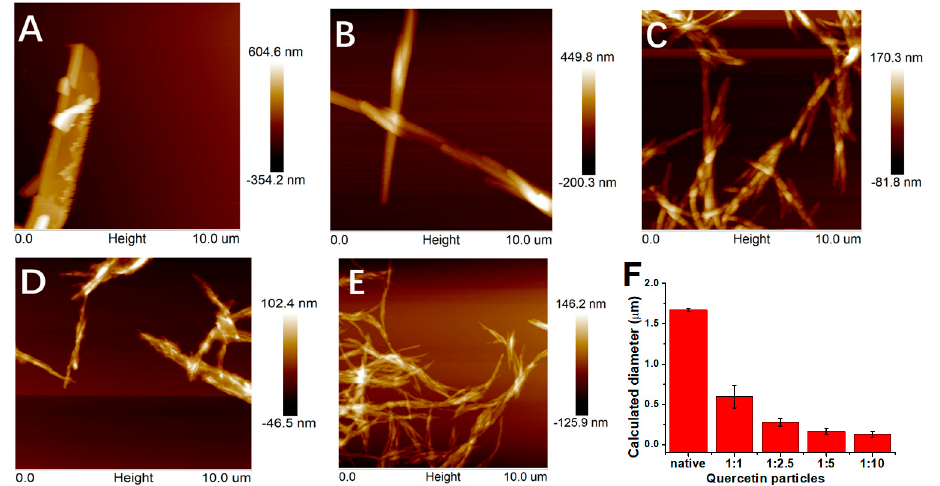
Figure 3. Atomic force microscopic images ( A − E ) and calculated diameter ( F ) of native quercetin ( A ) and quercetin particles formed by antisolvent precipitation with various antisolvent ratios (( B ), 1:1; ( C ), 1:2.5; ( D ), 1:5; ( E ), 1:10).